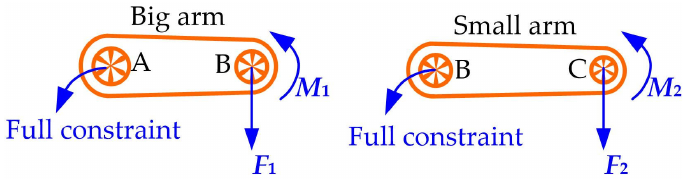
Figure 8. Application of loads and constraints.